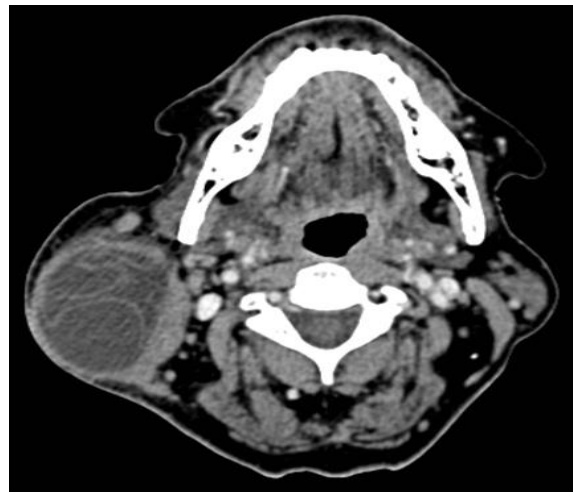
Figure 1: Axial a) noncontrast enhanced b) contrast- enhanced CT scan images demonstrates replacement of the entire right parotid by a cyst which shows linear tortuous structures within suggestive of ruptured